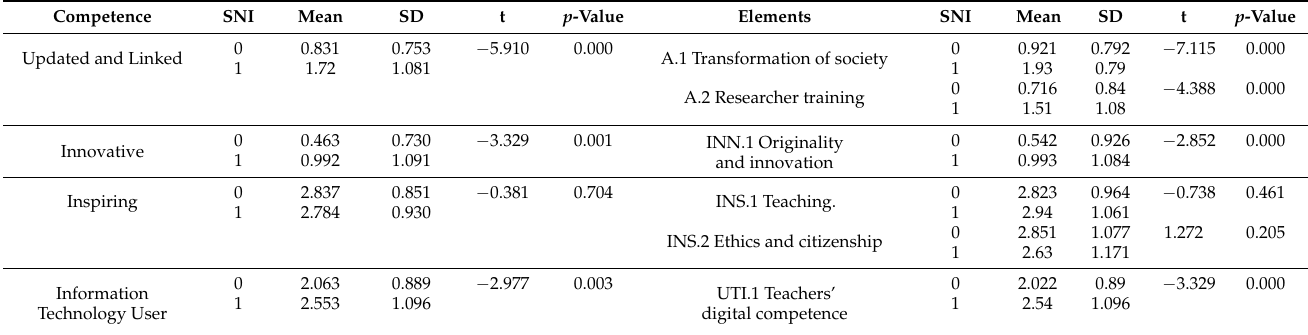
Table 9. Researchers in the SNI: 0 = does not belong (N = 59); 1 = if applicable (N =